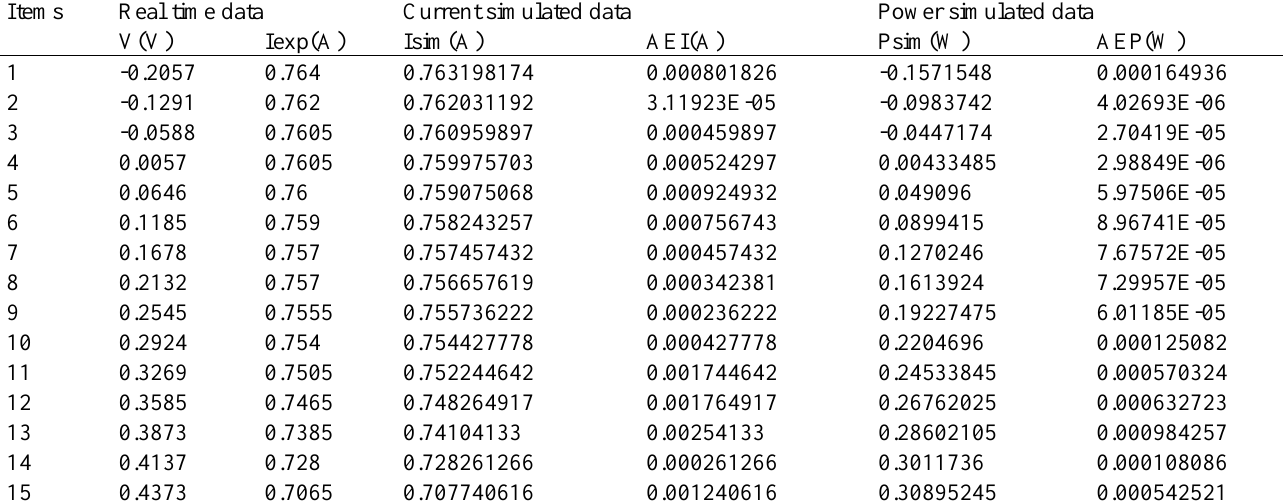
Absolute Error (AE) of Single Diode Model at the best Root Mean Square Error using